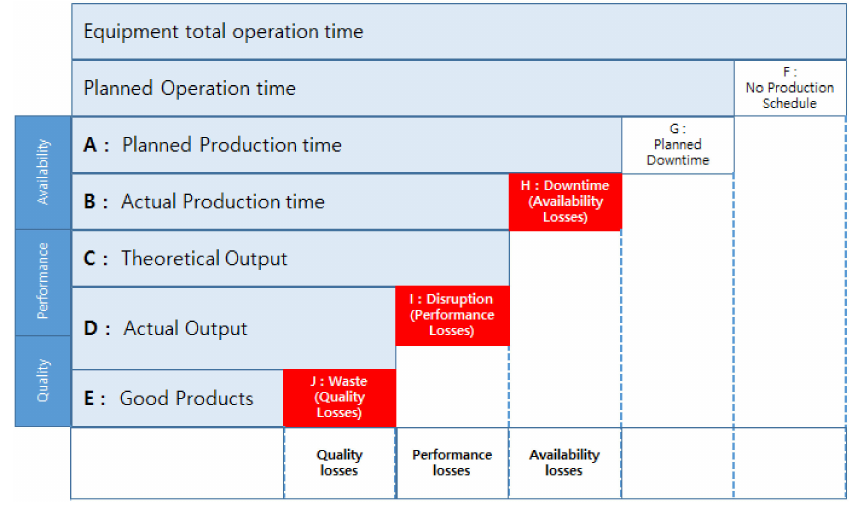
Figure 2. Decomposition of time elements related to overall equipment e ff ectiveness (OEE) and its